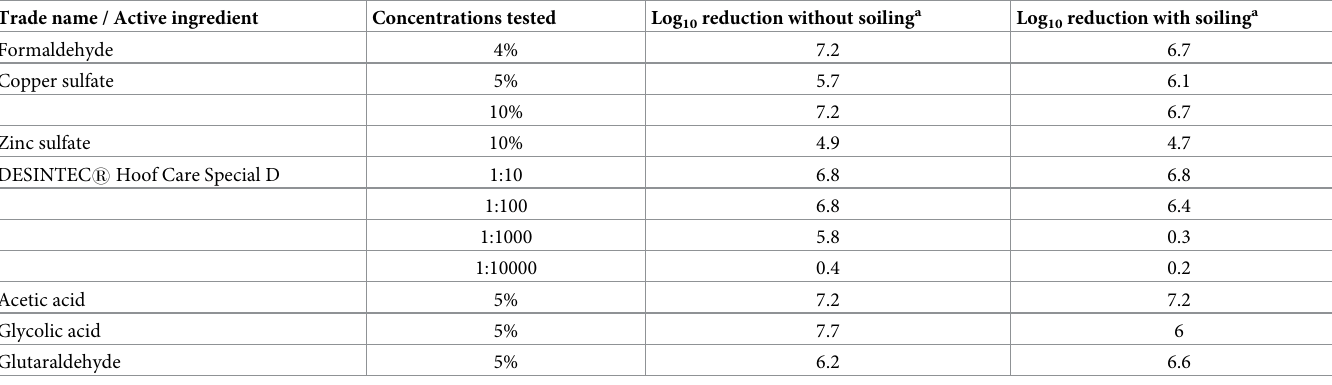
Table 3. Effectiveness of the tested disinfectants on growth reduction of D . nodosus . Trade name / Active